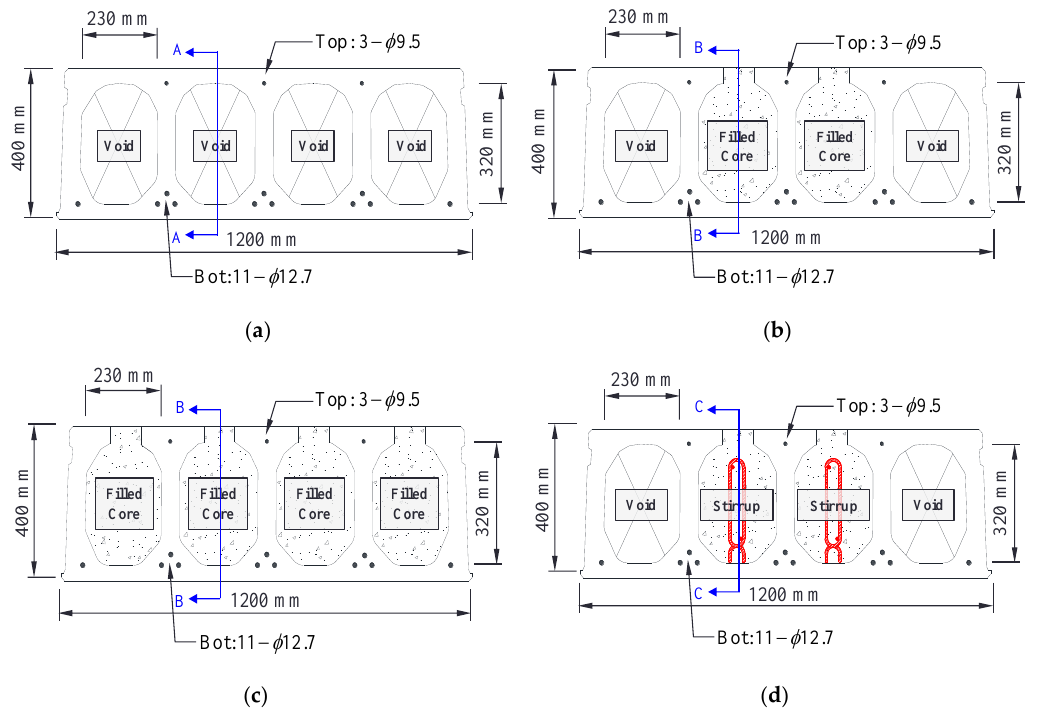
Figure 1. Section details of test specimens. ( a ) NR—0/4 specimen. ( b ) NR—2/4 specimen. ( c ) NR—4/4 specimen. ( d ) LR—2/4 and HR—2/4 specimens.